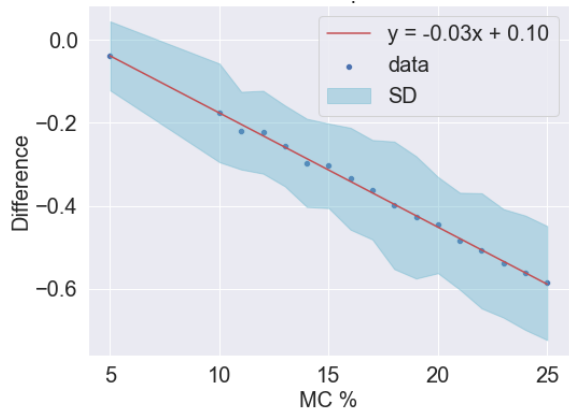
Figure 8(a & b). There is a linear relationship between soil MC and the difference between reflectance at 1720 and 1782nm.